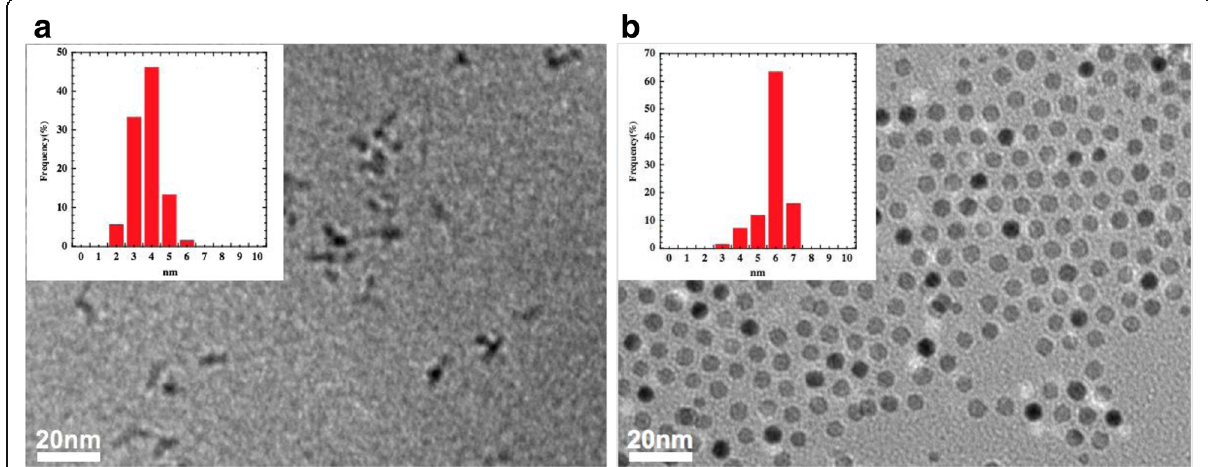
Fig. 1 TEM images and particle size histograms for nanoparticles of a CoFe 2 O 4 and b CoFe 2 O 4 @Ag